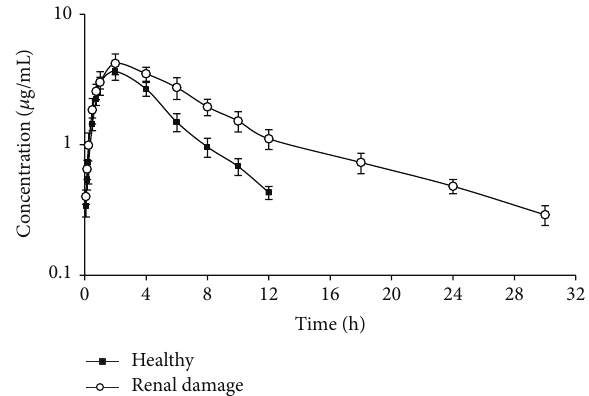
Figure2:Semilogarithmicplotoftheobservedmean ± SEdepicting the time and concentration of levofloxacin in plasma of healthy ( ◼ ) and renal damaged ( ] ) ducks after a single PO administration of 10 mg kg −1 bwt ( 𝑛 = 6